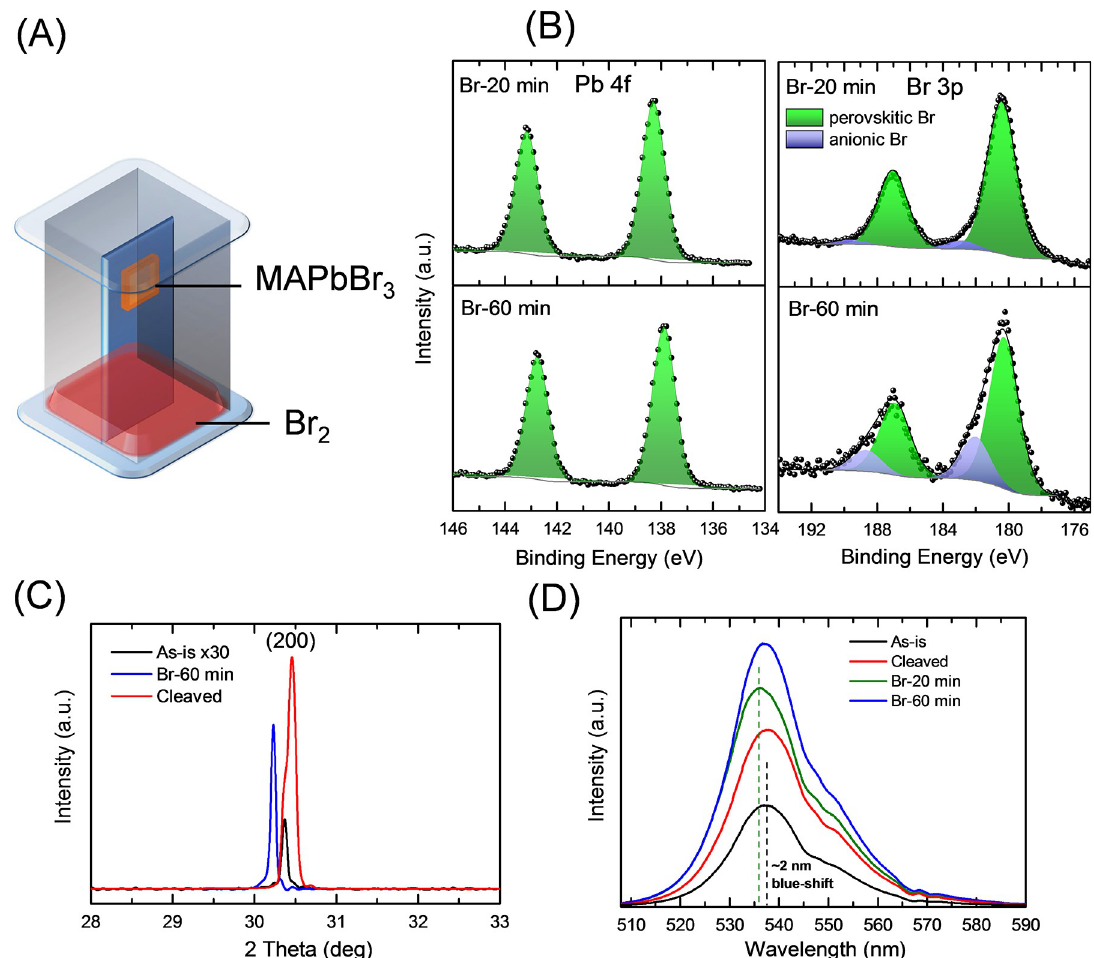
Fig 2. Bromine-vapor treatment. (A) Schematic showing the treatment process (B) XPS data showing the Pb 4f core peak from the top surface of the brominated crystals. Suppression of the Pb˚ peaks is found (C) XRD of the various MAPbBr 3 crystals showing the (002) scattering peak shift (D) PL peaks for the various conditions. A blue-shift of ca . 2 nm is observed after Br-vapor